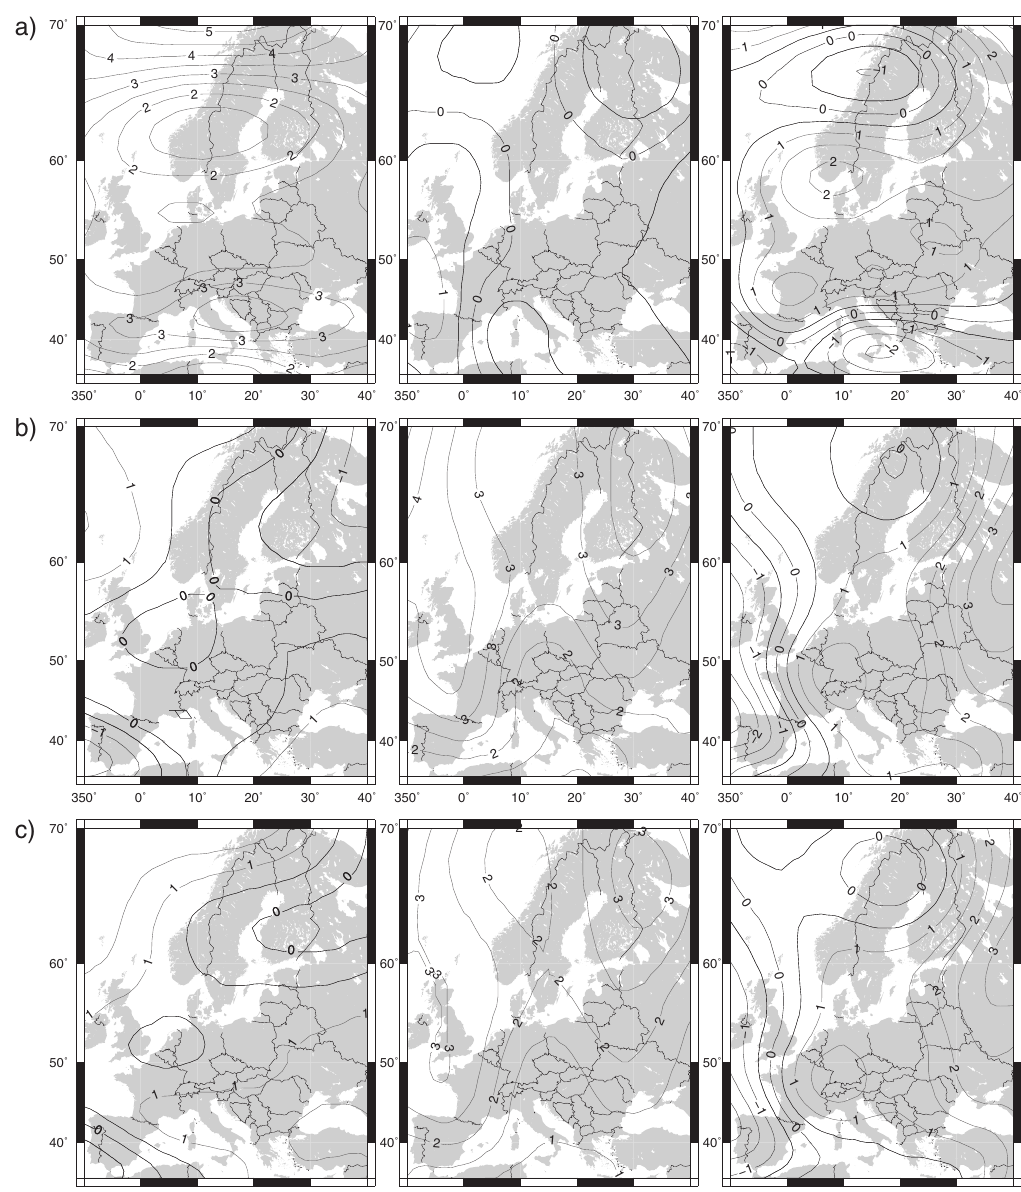
Fig. 7a-c. Maps of the X (left), Y (center) and Z (right) secular acceleration components at epochs around 1970 obtained from EU_MIX model. The largest areas of zero SA are seen in 1969.3 for Y (top), 1970.3 for X (mid- dle) and 1970.1 for Z component (bottom). Note that data resolution is one year and the decimal years reflect the smoothness quality of the model. Units nTyr –2 . Mercator map